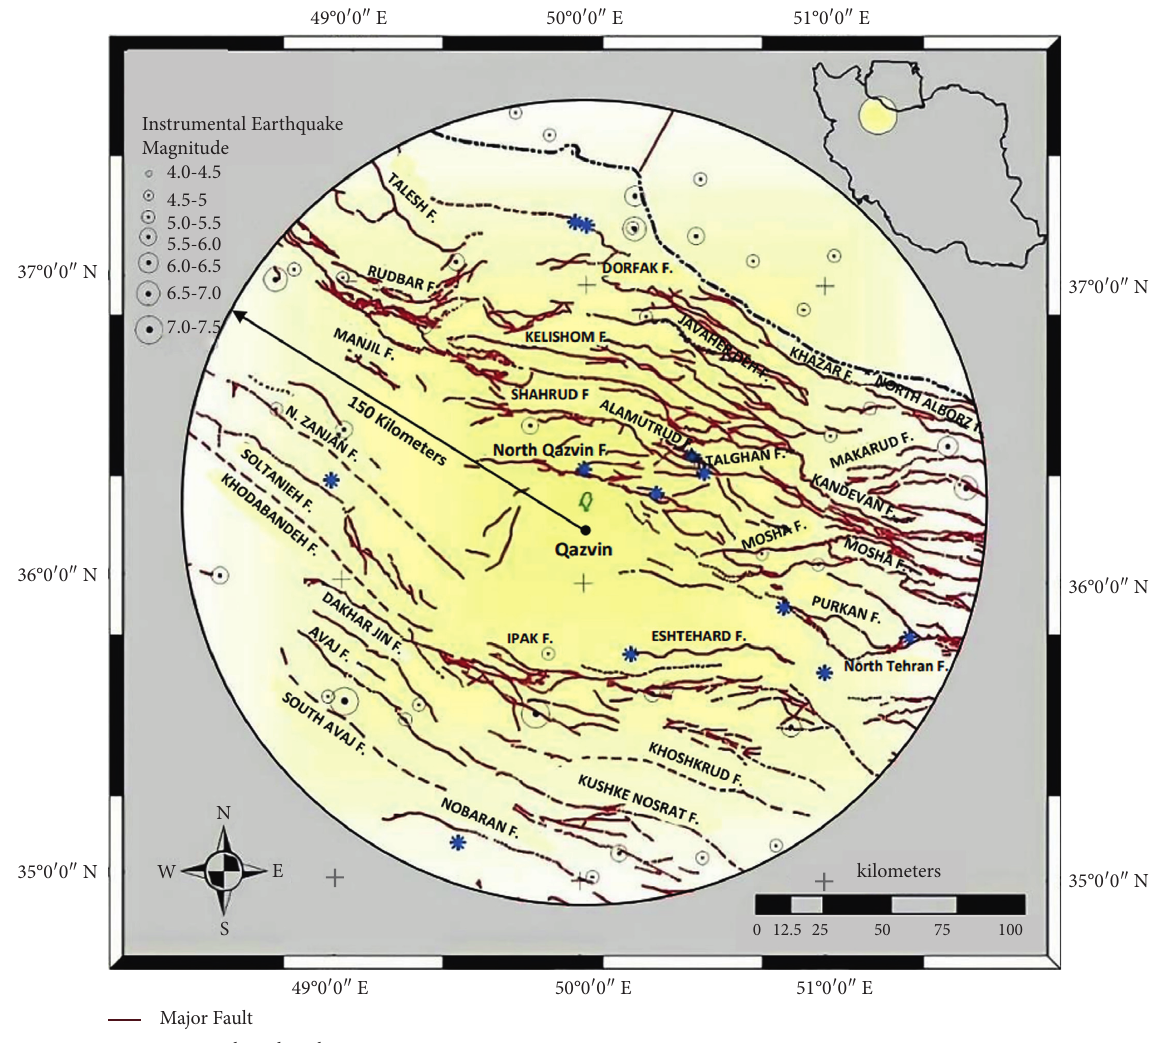
Figure 4: Seismotectonic map within a radius of 150km around the city